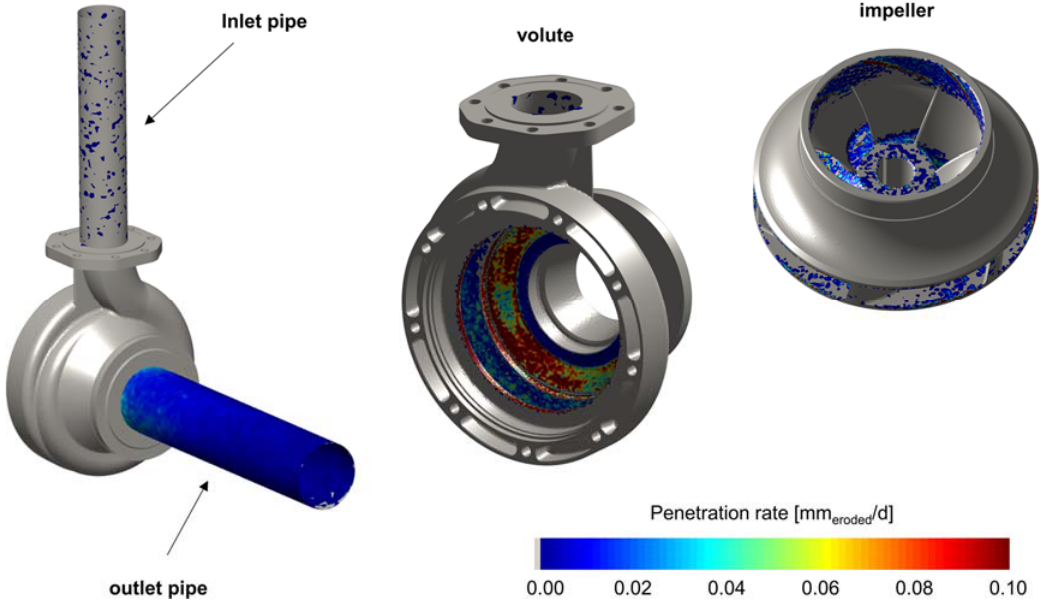
Figure 3. Penetration rate for PAT parts (2.5 M mesh resolution; NP =